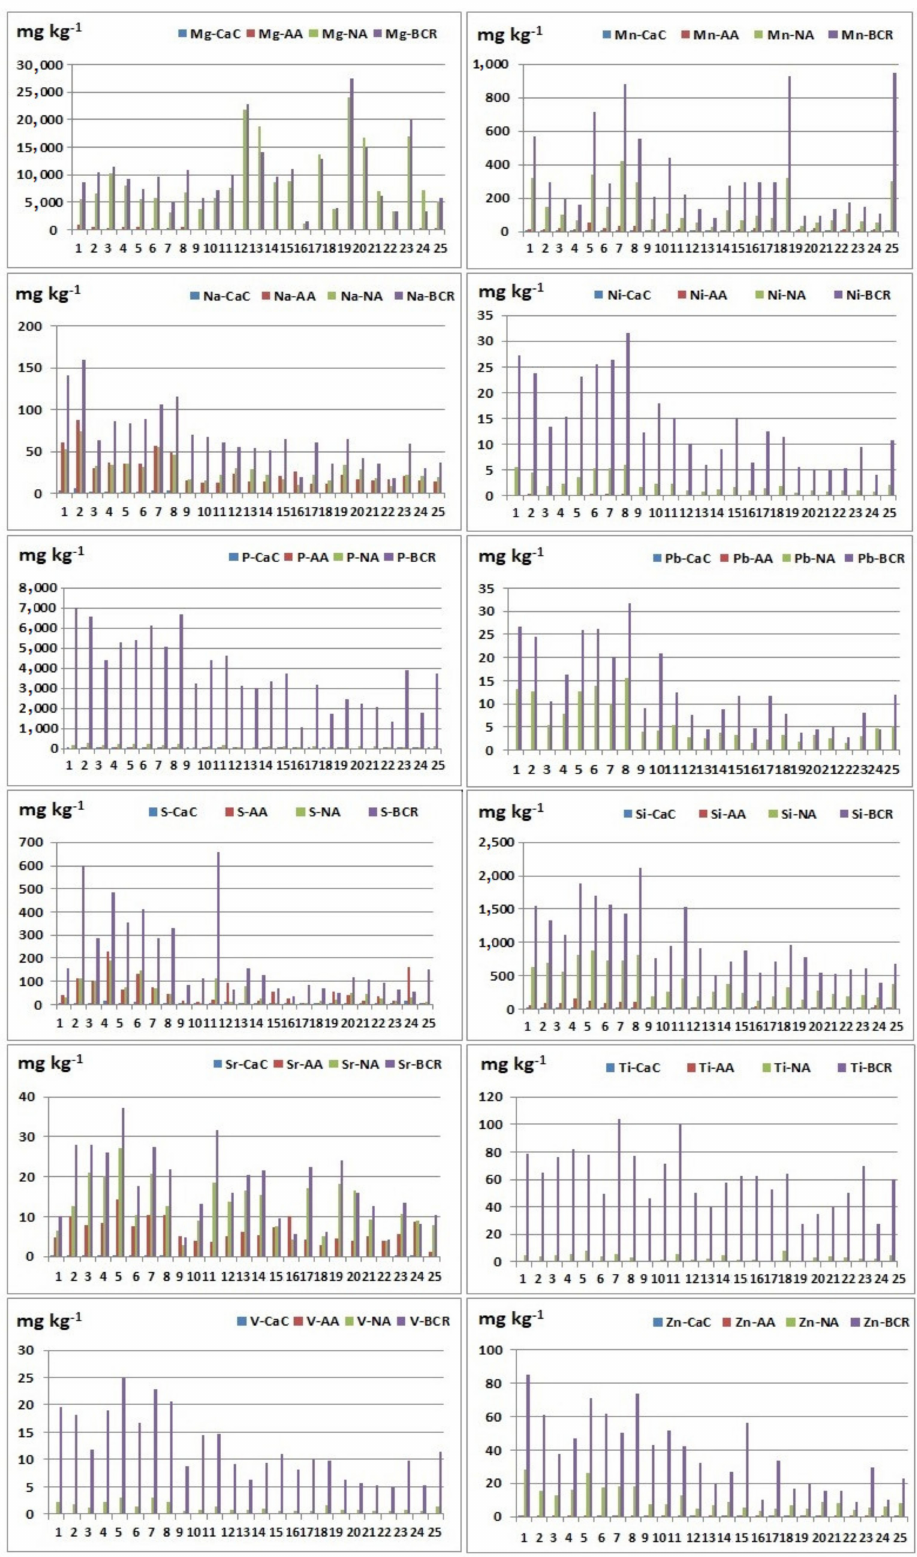
Figure 3. Extracted element contents (Mg, Mn, Na, Ni, P, Pb, S, Si, Sr, Ti, V, and Zn) using different reagents: CaC —calcium chloride; AA —ammonium acetate; NA —nitric acid; BCR —total element content (extracted element using BCR extraction